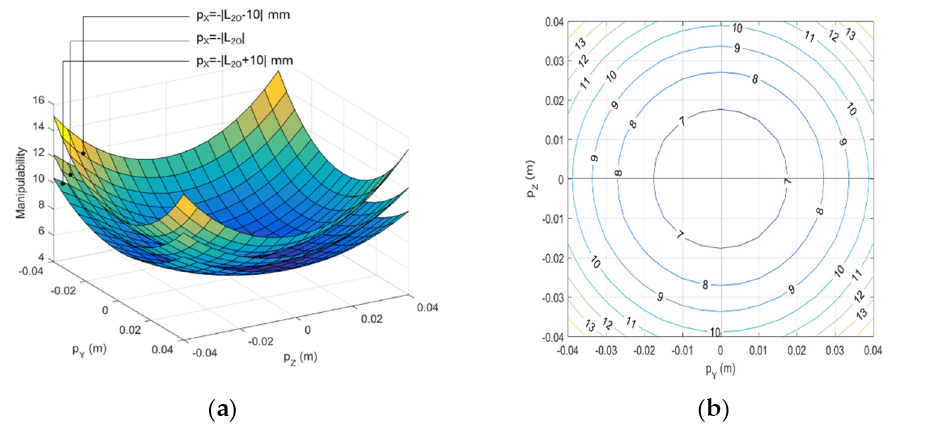
Figure 7. Manipulability: ( a ) oblique view; ( b ) contour map.